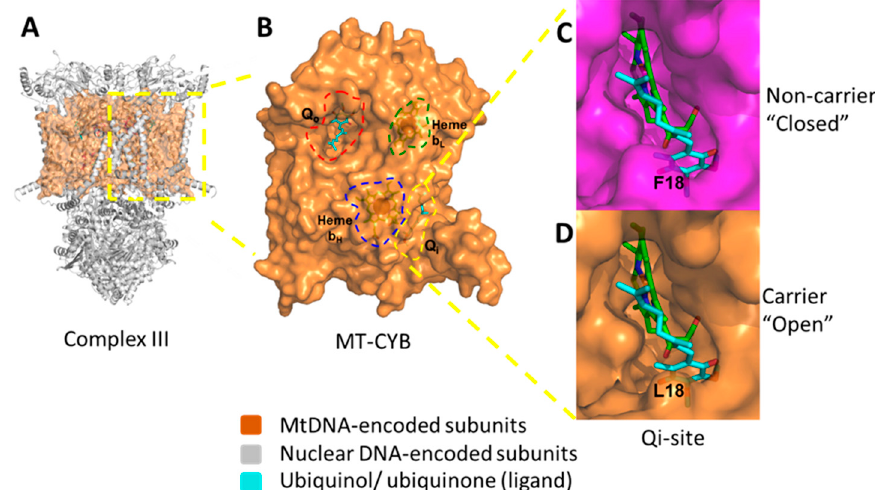
Figure 8. Structural consequences of the inherited homoplasmic mutation F18L found frequently in the glioblastoma complex III mitochondrial protein; MT-CYB. ( A ) The dimeric structure of complex III with the nuclear-encoded subunits shown as ribbons (grey) and mitochondrial-encoded subunit, MT-CYB, shown as a space filling model (orange). ( B ) Key functional sites within MT-CYB are highlighted; the Qo-site which binds ubiquinol (cyan sticks, red dashed lines), the Qi-site which binds CoQ10 (also known as ubiquinone) (cyan sticks, yellow dashed lines), heme bL (orange sticks, green dashed lines) and heme bH (orange sticks, blue dashed lines). ( C ) The “closed” Qi-site pocket (top, magenta) present in non-carriers adult glioblastoma cell lines UP-029 and SNB19. ( D ) The “open” Qi-site pocket (bottom, orange) present in F18L-carriers adult glioblastoma cell lines SEBTA-023 and UP-007. Bound ubiquinone is shown as sticks (cyan) in both cases. F18L, through the changes to the local structural environment shown, is predicted to lead to alternative modes of CoQ10 association /